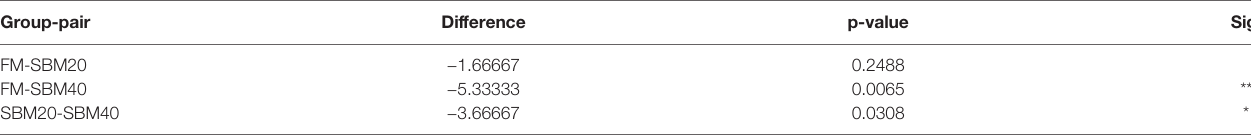
*Represents p < 0.05; **represents p <